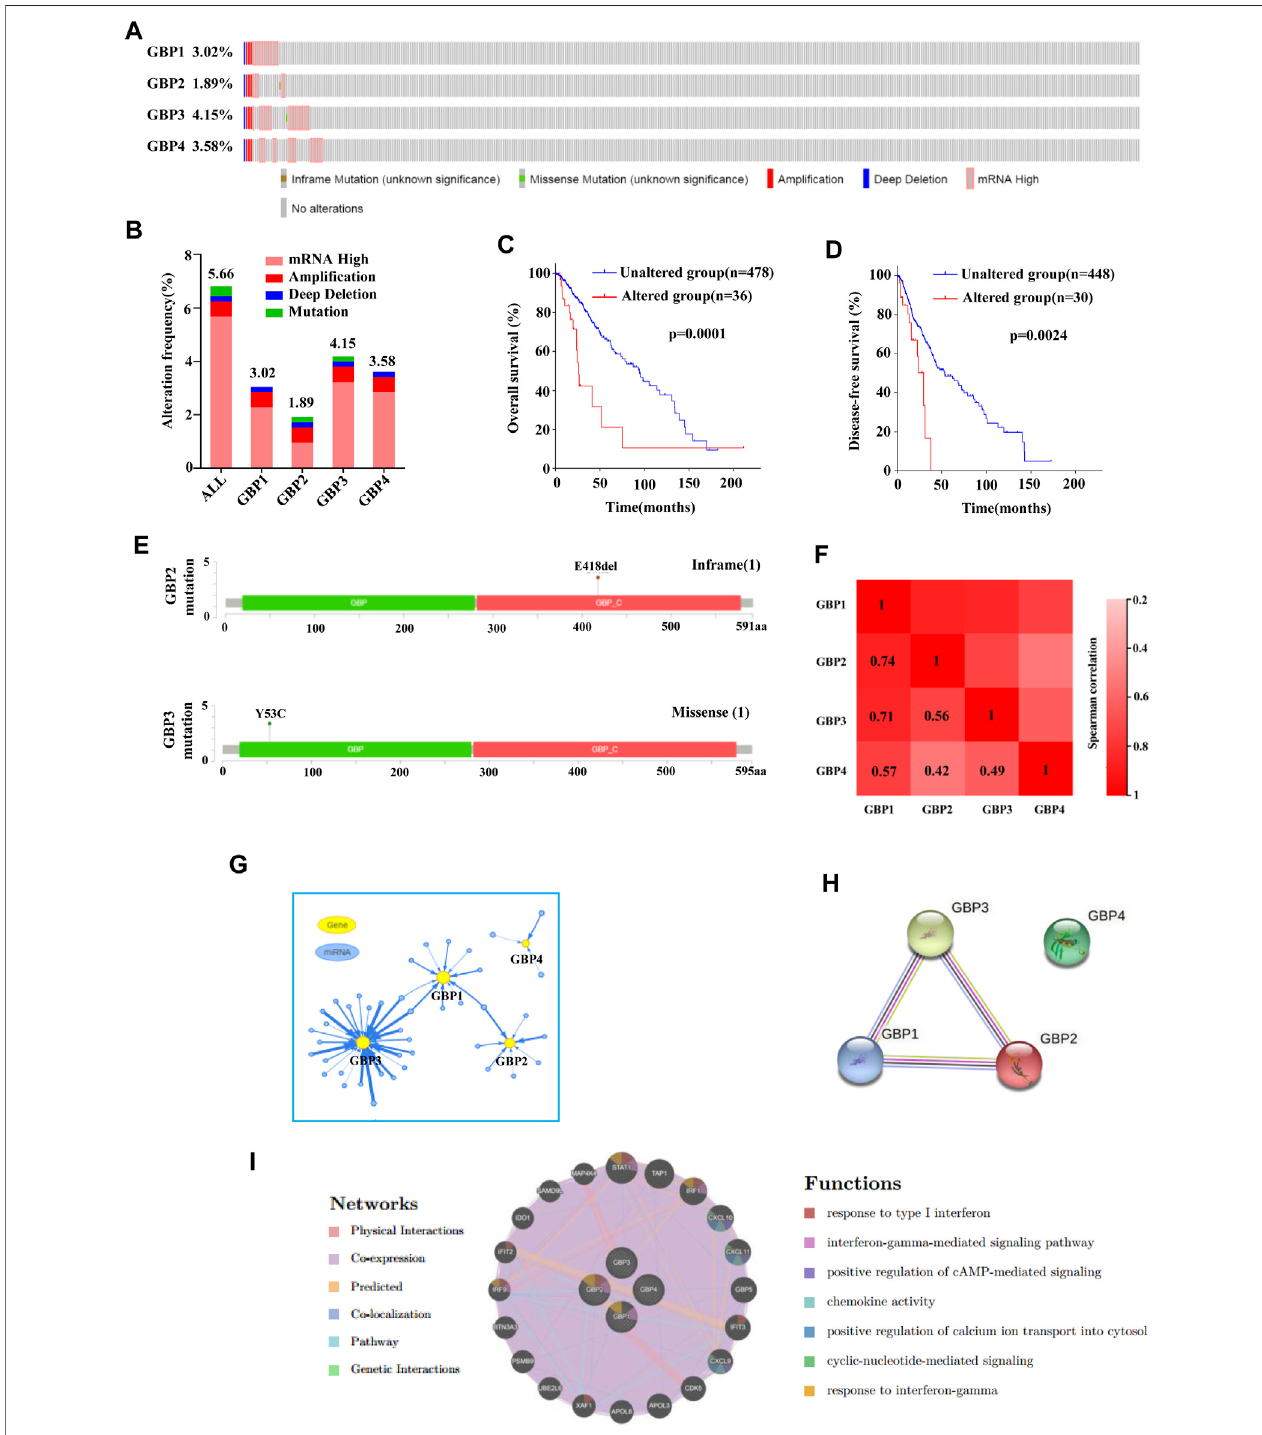
FIGURE 7 | Gene alterations, co-expression, interaction network analysis of GBP1, 2, 3, 4 in LGG. (A, B) Summary of gene alterations of GBP1, 2, 3, 4 in LGG (cBioPortal). (C,D) Overallsurvivalanddisease-freesurvivalanalysisresultsofGBP1,2,3,4genealterations(cBioPortal). (E) ThemutationsofGBP2and3wereplotted (cBioPortal). (G) miRNA network ofGBP1, 2, 3, 4 in LGG (GSCALite). (H) Protein – proteininteraction network ofGBP1, 2, 3, 4 (STRING). (I) The interaction network and function prediction of GBP1, 2, 3, 4 (GeneMANIA).